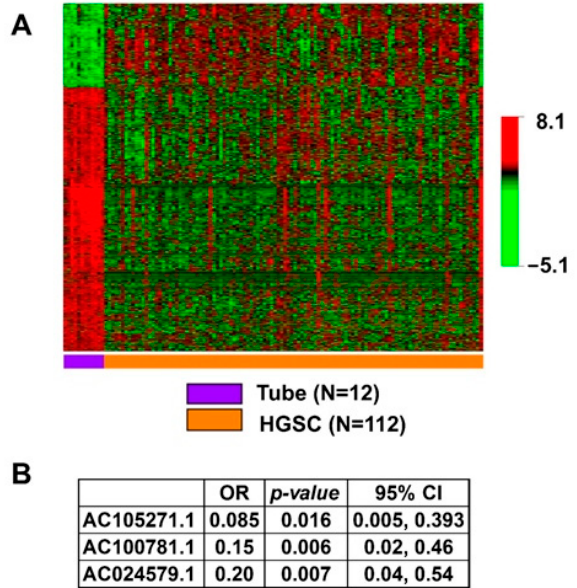
Figure 2. Association of lncRNA with HGSC. ( A ) Heatmap showing statistically significant, differ- ential lncRNA expression between HGSC and normal tube in the univariate analysis with p < 0.001, N = 1943. ( B ) Independently significant lncRNA in the multivariable model of association with HGSC.